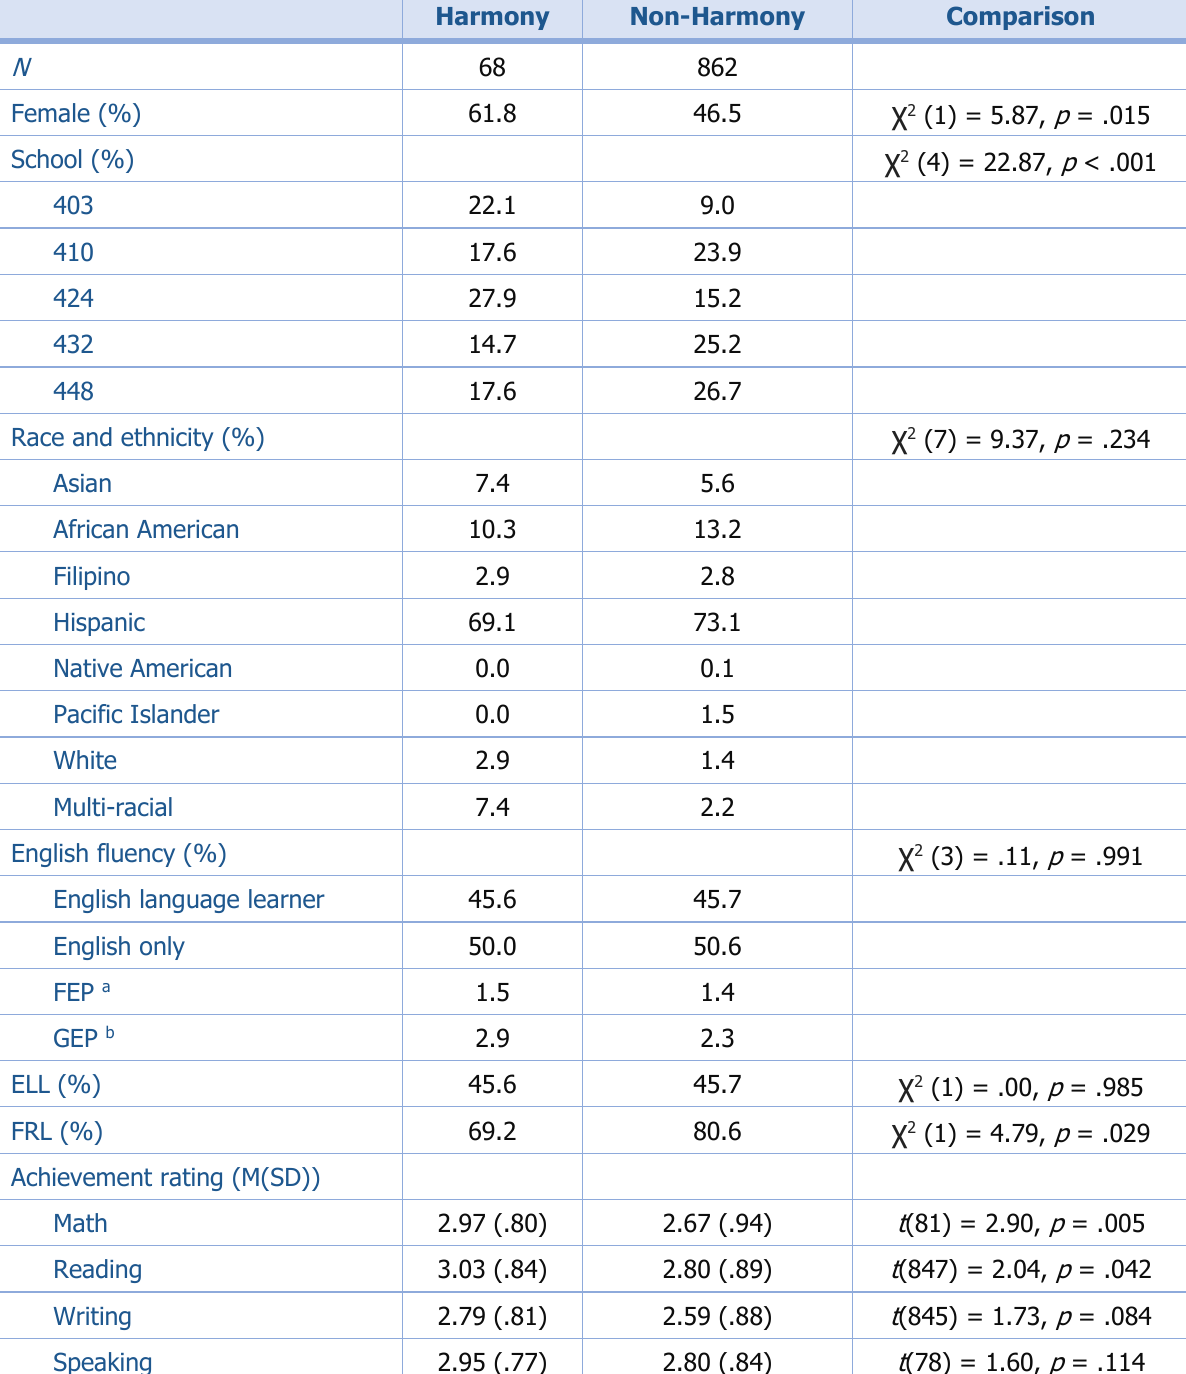
Table 3. Demographic and Academic Characteristics of Harmony and Non-Harmony Students for 2-Year